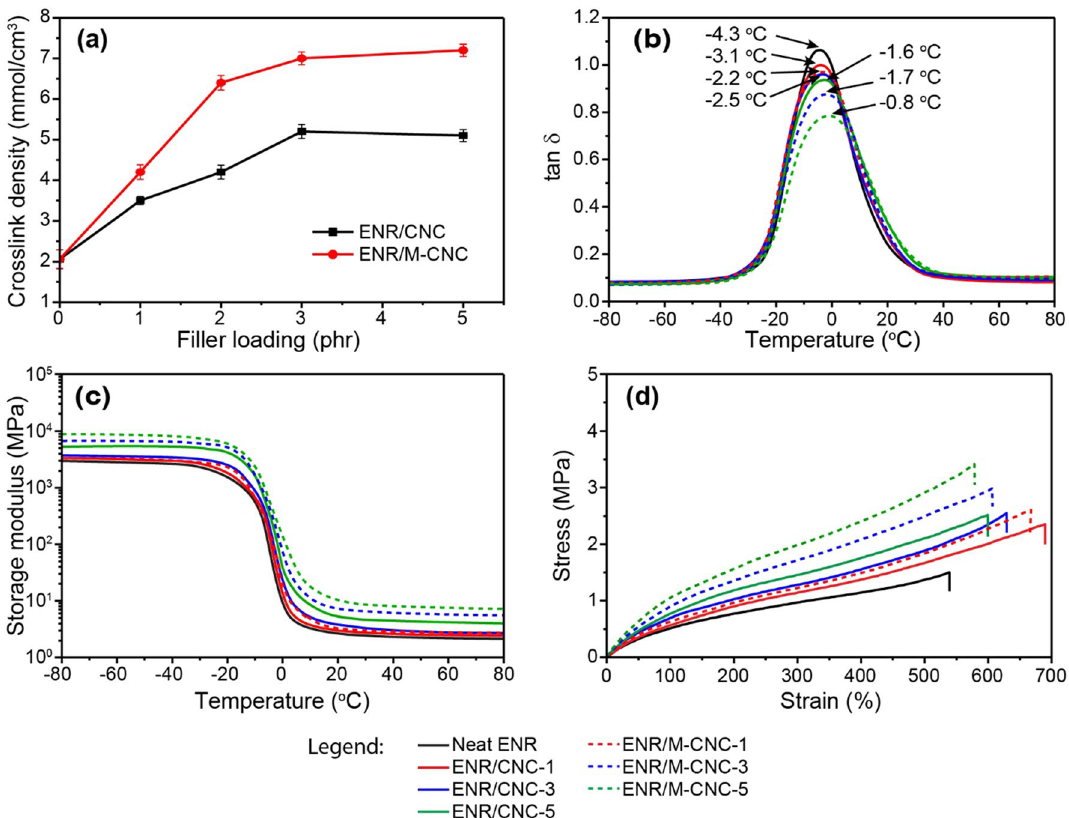
Figure 5. ( a ) Crosslink density, ( b ) tan δ versus temperature curves, ( c ) storage modulus (E ′ ) versus temperature curves ( d ) tensile stress–strain curves of the